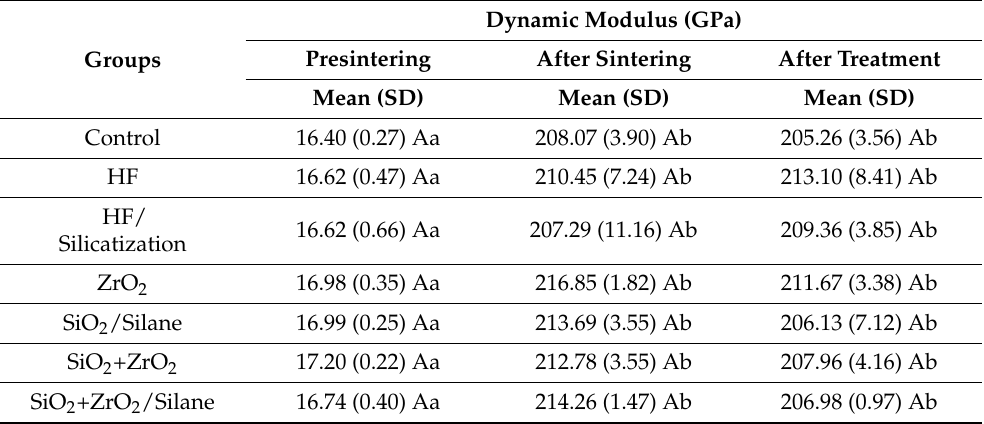
Figure 6. Failure mode analysis. Table 4. Dynamic modulus (GPa) of bar-shaped specimens are presented as mean (standard deviation) before sintering, after sintering, and after surface